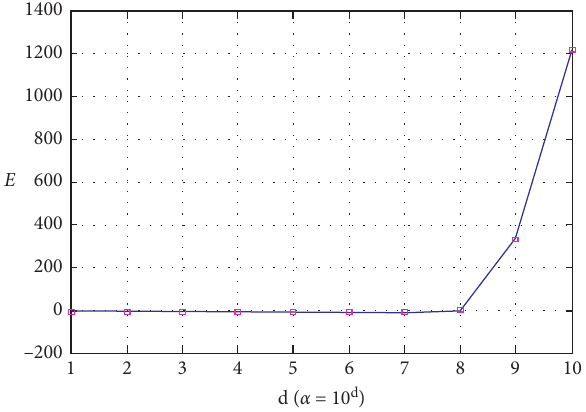
Figure 2: Influence of a penalty factor α on objective function values.